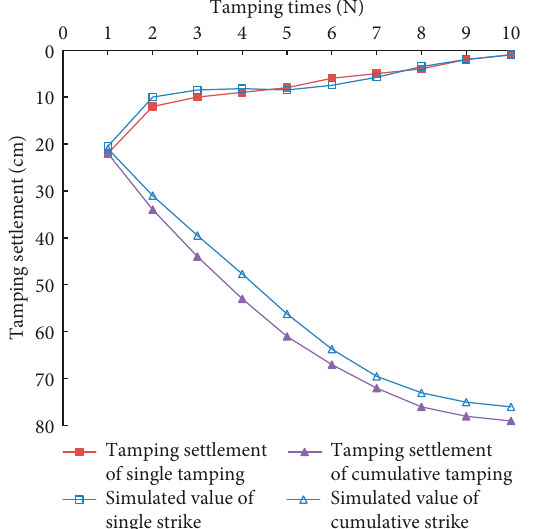
Figure 14: Comparison of field measured data and simulation test